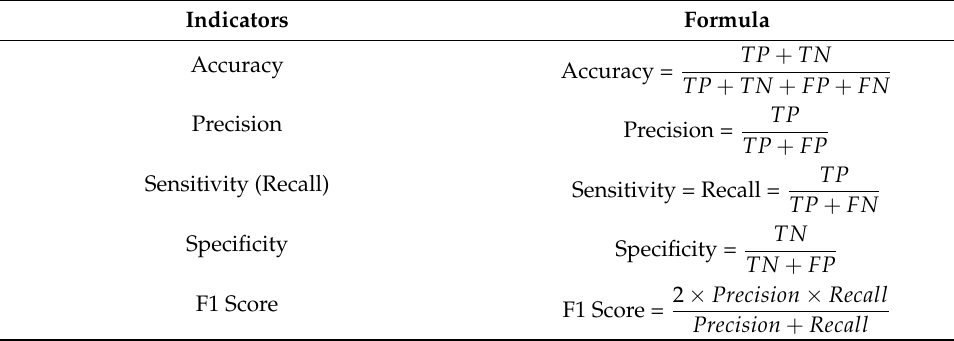
Table 2. Confusion matrix indicator